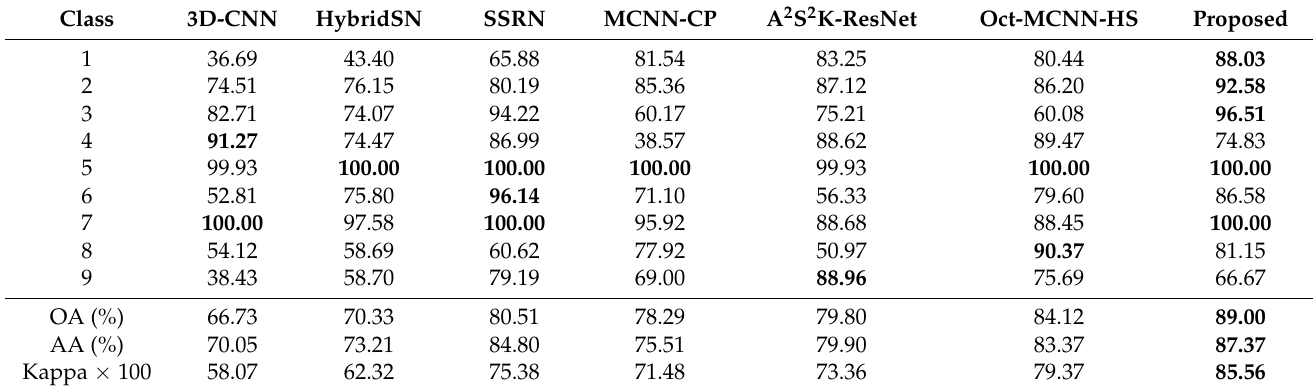
Table 8. The classification accuracy of different methods on the PU dataset.